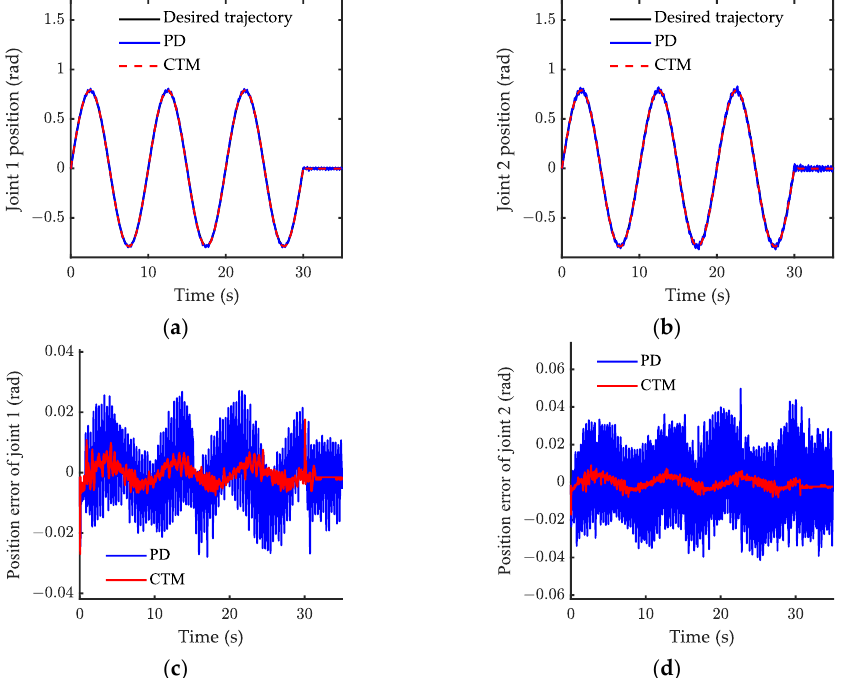
Figure 21. Experiment result of joint 1 position for case 2: ( a ) joint 1 position; ( b ) joint 2 position; ( c ) position error of joint 1; ( d ) position error of joint 2.